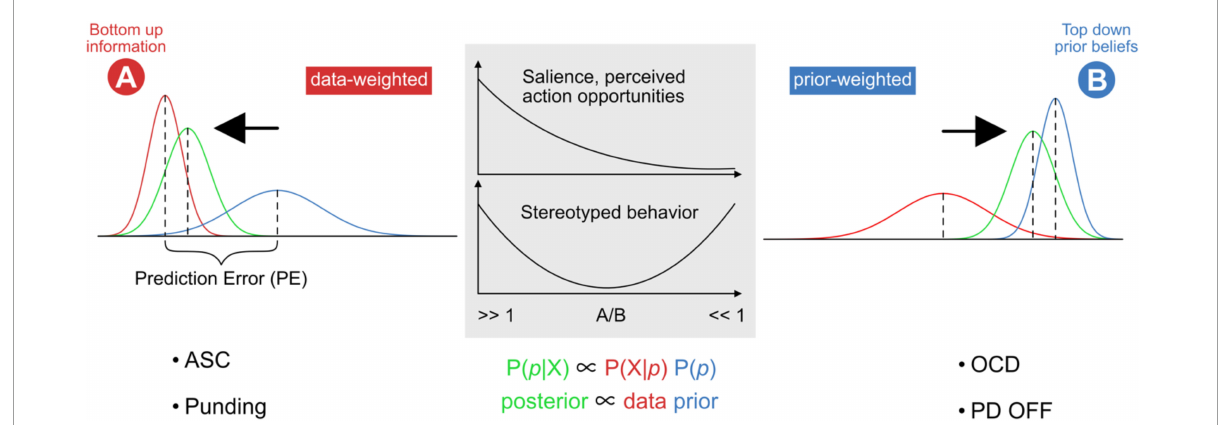
FIGURE2 Model of externally versus internally weighted dynamics in predictive processing. The probability distribution and precision of posterior beliefs (posterior; green) are proportional to bottom-up sensory information ( A ; data; red) and top-down prior expectations ( B ; prior; blue). The output of the basal ganglia contributes to setting the relative weighting between data and priors, by influencing the relative gain between external (exteroceptive) and internal (predictive) signals. Stronger relative weighting on prior beliefs increases the resistance to switching away from the current state or trajectory. Stereotyped repetitive behaviors might appear at both far ends of this spectrum. Overfitting describes the situation where a model accounts for too much detail and random fluctuations at the expense of generalizability (“data-weighted”). An under-fitted model regularizes too much and does not adjust sufficiently for relevant deviation in the data (“prior-weighted”). ASC and PD-on phenomena such as punding can be placed on the left side, OCD and PD-OFF on the right. Further description in the text.